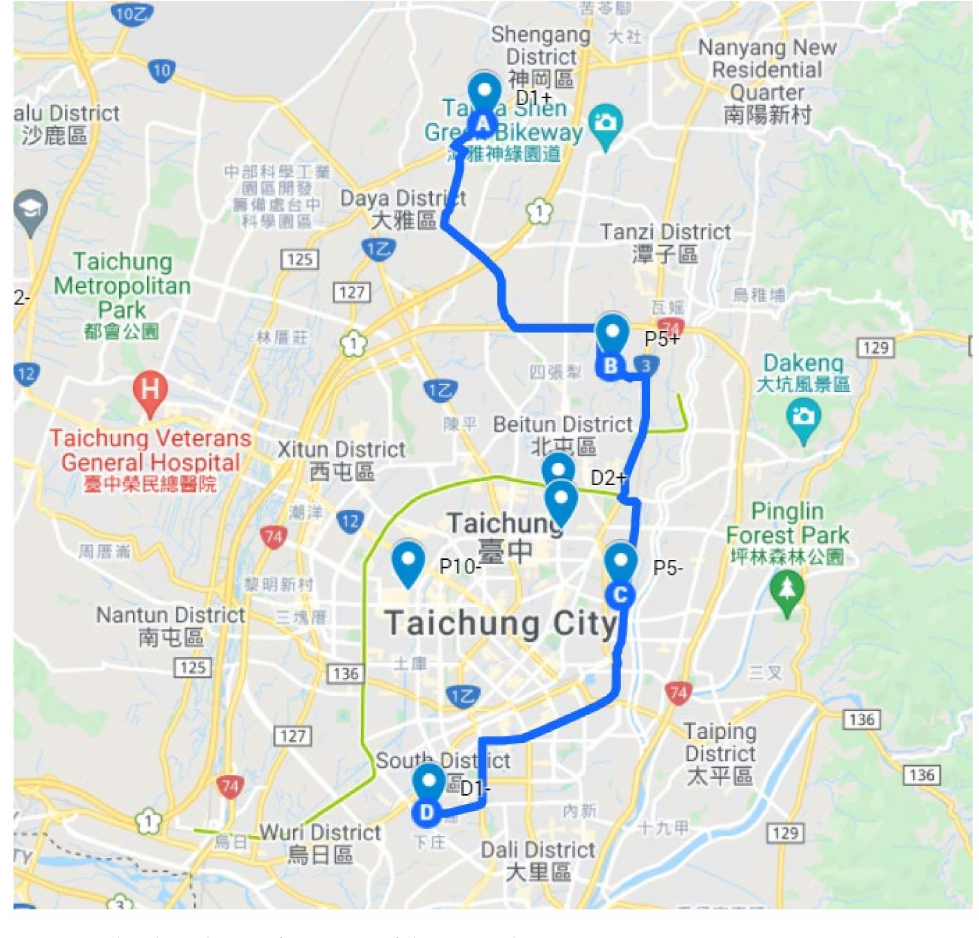
Figure 2. The shared route for Case 2 of the